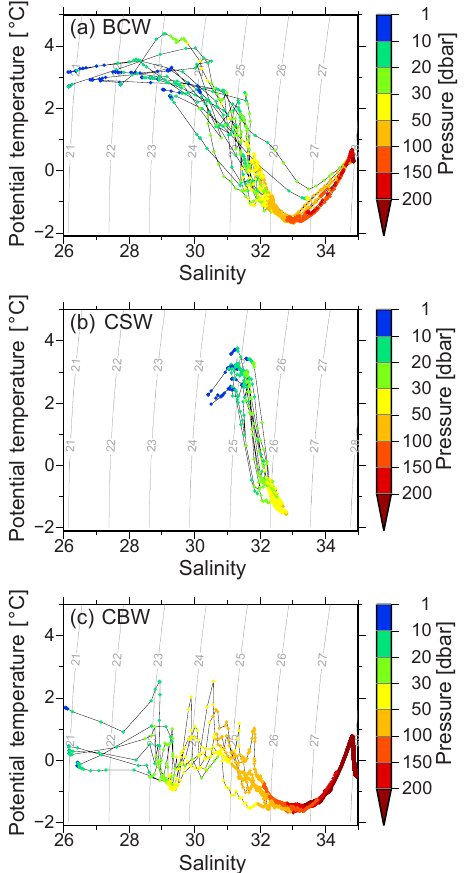
Figure 4. Column salinity and potential temperature in (a) BCW (Barrow coastal water), (b) CSW (Chukchi Sea water), and (c) CBW (Canada Basin water). Water pressure is in- dicated by color. Gray contours indicate potential density ( σ θ = {density − 1} × 1000 [kgm − 3